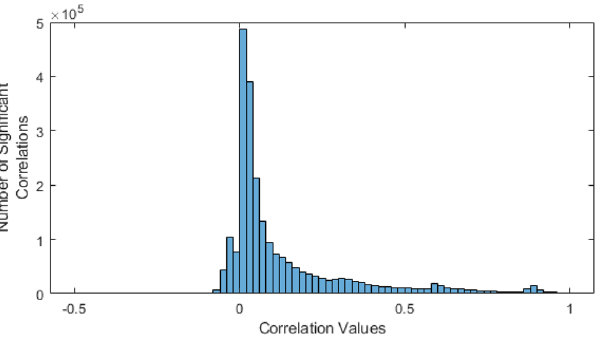
Figure 7. Histogram of significant correlation values across all analysed recordings. 88.4% of the significant correlations were